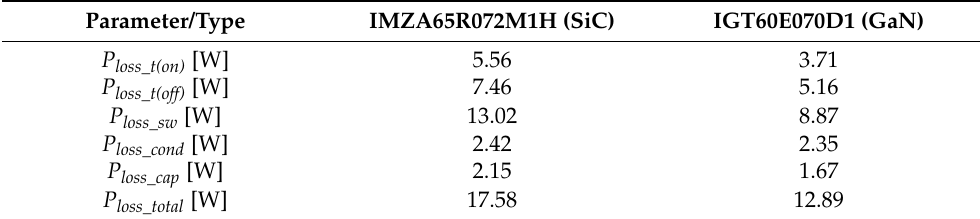
Table 6. Comparison of individual parts of power losses for selected